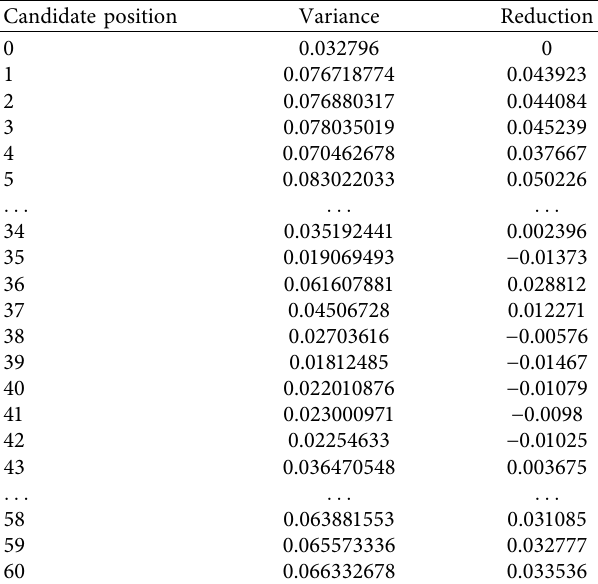
Table 6: Part of the results of node comprehensive importance variance. Position 0 represents the original network.